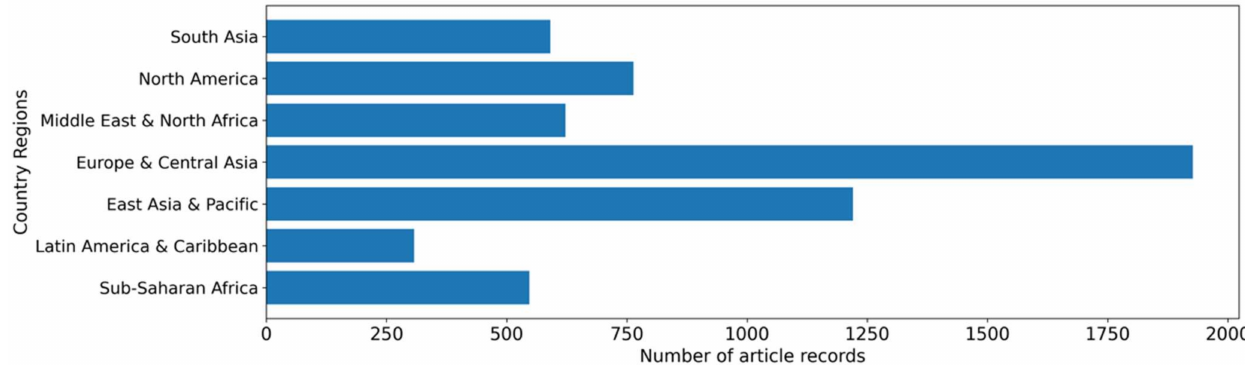
Figure 5. Article record distribution by World Bank regions from 1990–2020 ( n = 12,368). There is limited AMR research and knowledge dissemination globally prior to the year 2000; however, since 2010, there has been a substantial increase in AMR One Health focus (Figure 6).